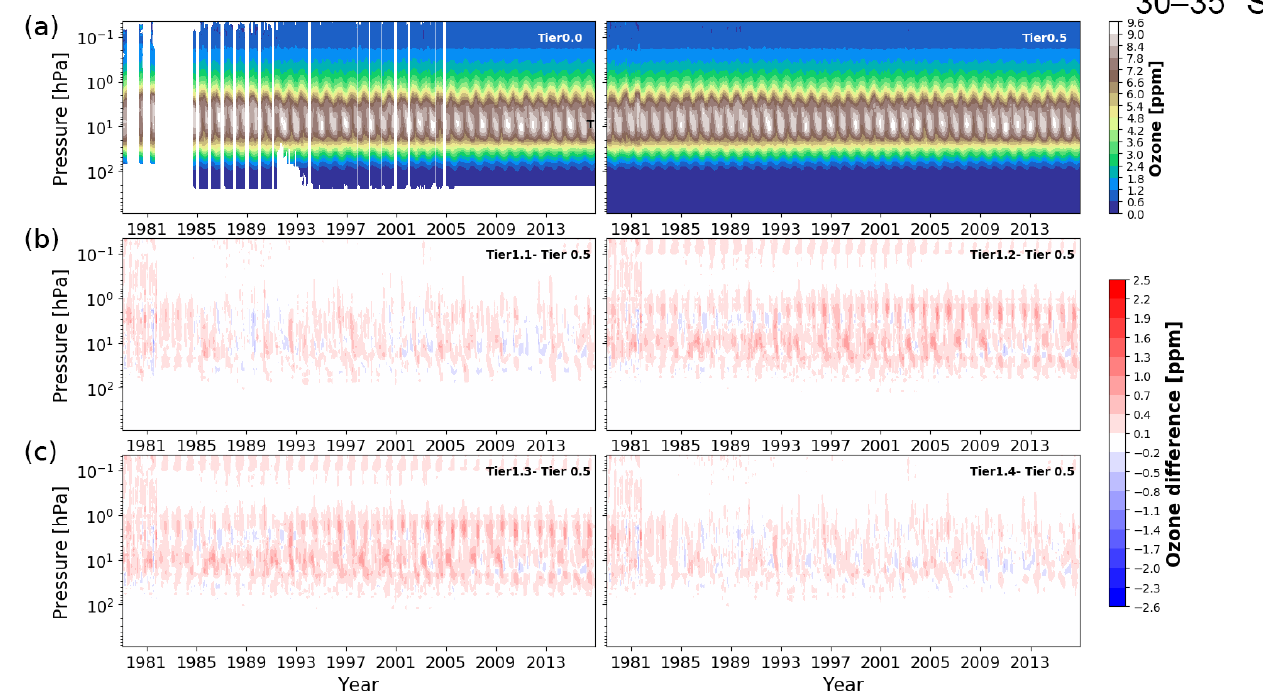
Figure 6. Tier 0 and 0.5 of BSVertOzone for the latitude band 30 to 35 ◦ S, given in ozone mixing ratio on pressure levels (a) . The differences between Tier 1.x and Tier 0.5 are shown in (b) and (c) for Tier 1.1 to Tier 1.4.